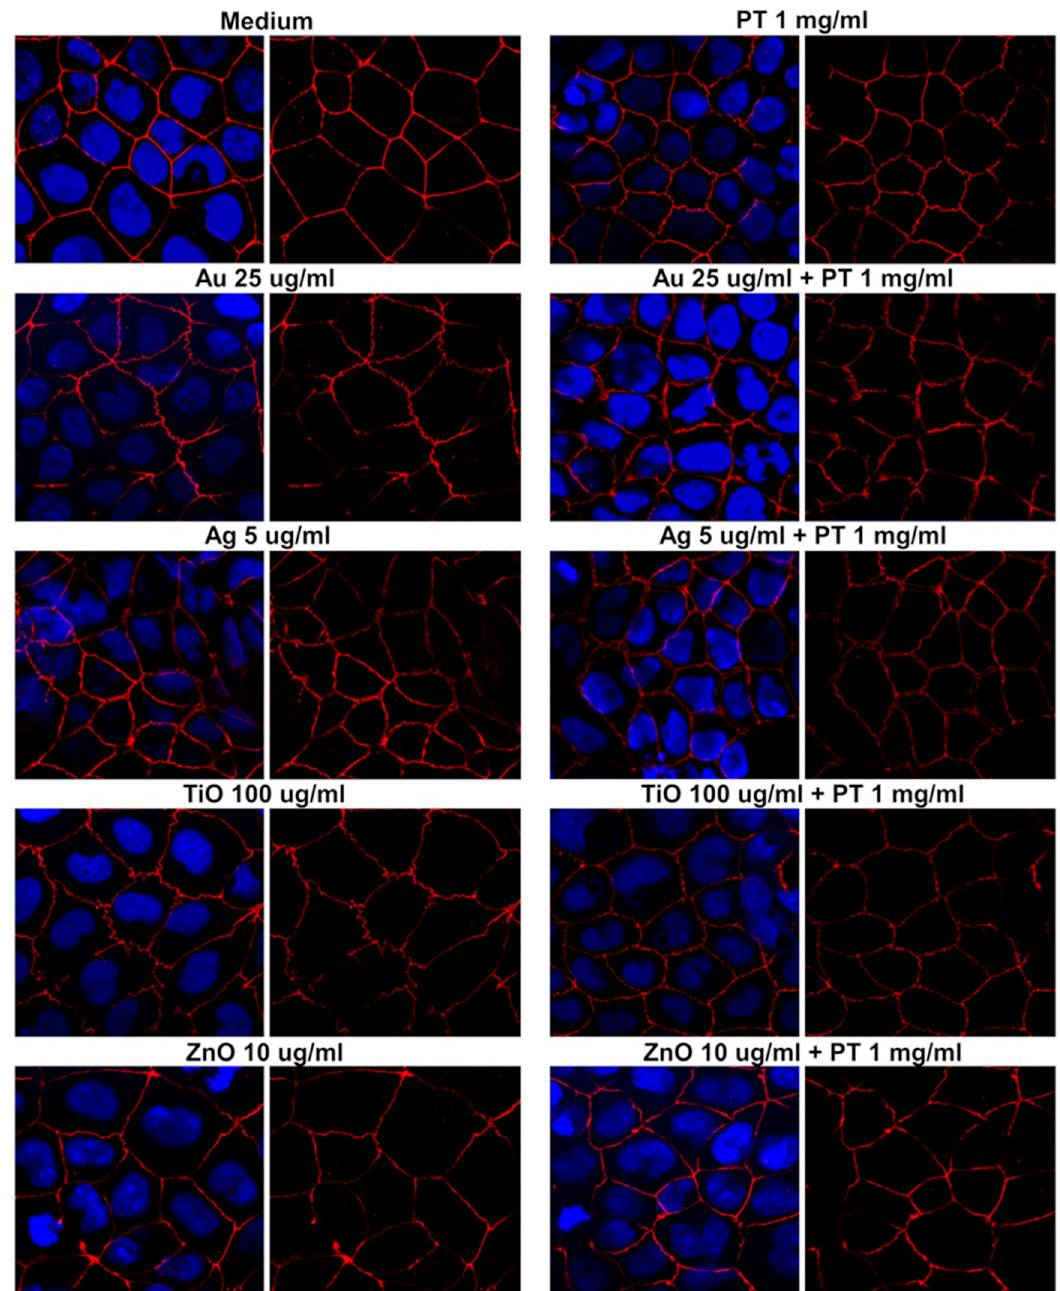
Figure 6. Zonula occludens-1 immunofluorescence in post-confluent Caco2 cells. Left panels show the overlay with 4 ′ ,6-diamidino-2-phenylindole (DAPI), and right panels show the ZO-1 signal alone (63× magnification).